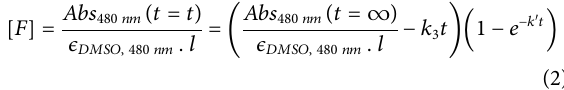
FIGURE 3 Formazan concentration ([F]) as a function of illumination time for three different intensities and their corresponding model fi ts. (black ■ : 56 mW cm − 2 ; blue ▲ : 101 mW cm − 2 ; red C : 455 mW cm − 2 ).